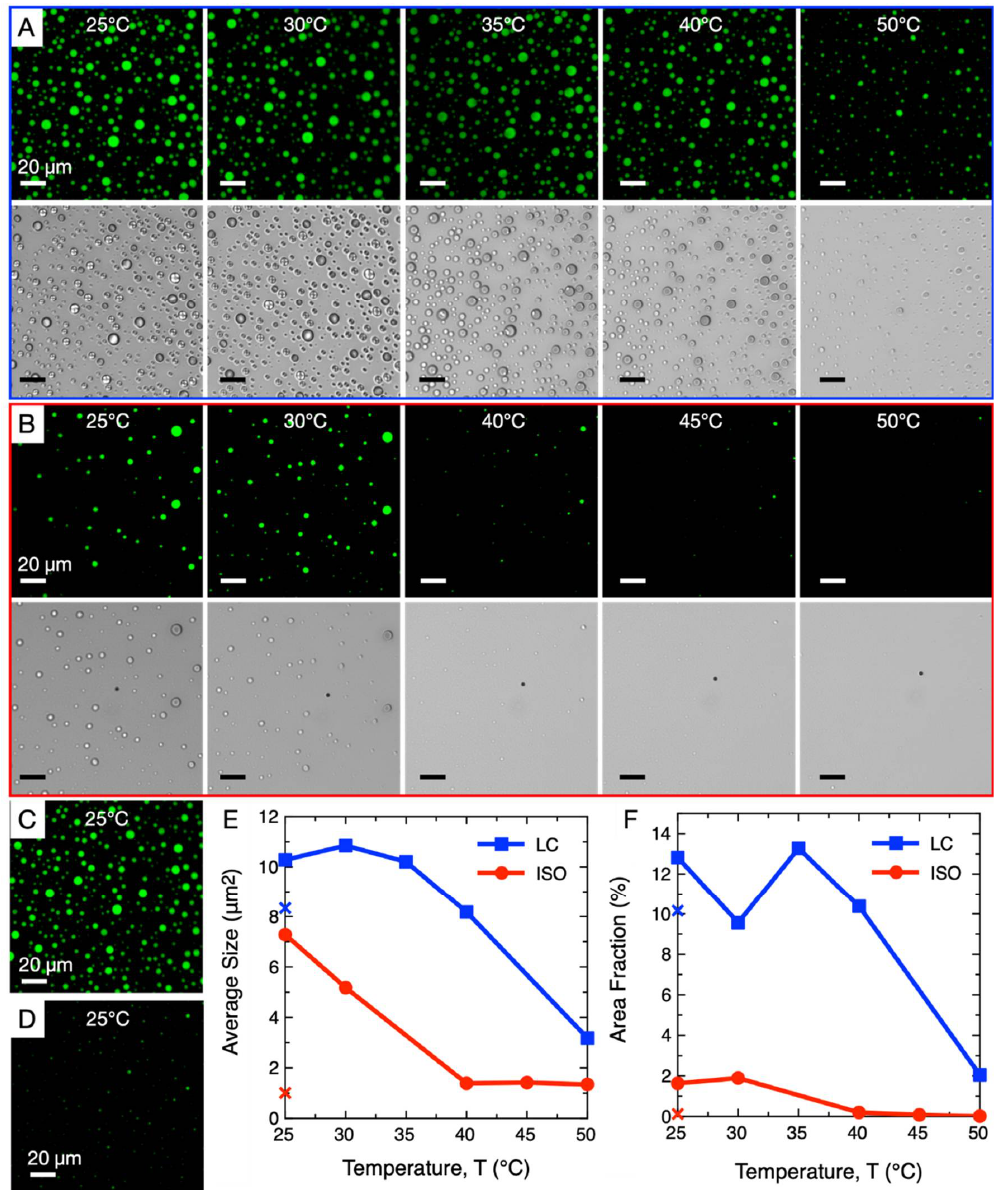
Figure 2. Thermal stability of LC-coacervates and LC phase-lacking isotropic coacervates. ( A ) Fluorescence (top, SYBR Gold) and polarization (bottom) microscopy images of PLL (N = 10 mM) and rDD (P = 10 mM) coacervate droplets at 800 mM NaCl exhibiting LC phase assembly undergoing heating up to 50 °C. ( B ) Fluorescence (top, SYBR Gold) and polarization (bottom) microscopy images of PLL (N = 10 mM) and rDD (P = 10 mM) coacervate droplets at 900 mM NaCl, exhibiting no LC phase assembly (isotropic), undergoing heating up to 50 °C. ( C ) A LC-coacervate sample from (A), after heating to 50 °C (slight disassembly), was returned to 25 °C and imaged. The sample re-assembled into coacervate droplets roughly similar in size to their original size before heating. ( D ) An ISO coacervate sample from (B), after heating to 50 °C (slight disassembly), was returned to 25 °C and imaged. The sample did not appear to reassemble into coacervate droplets. ( E , F ) Average size (E) and total droplet area within the viewing frame (F) vs. T of both samples, LC phase-containing (blue squares) and ISO droplets (red dots). The crosses represent the average size and total droplet area (within the viewing frame), respectively, of both samples (LC in red, ISO in blue) after reducing the temperature from 50 °C to 25 °C. Scale bars are 20 µm.